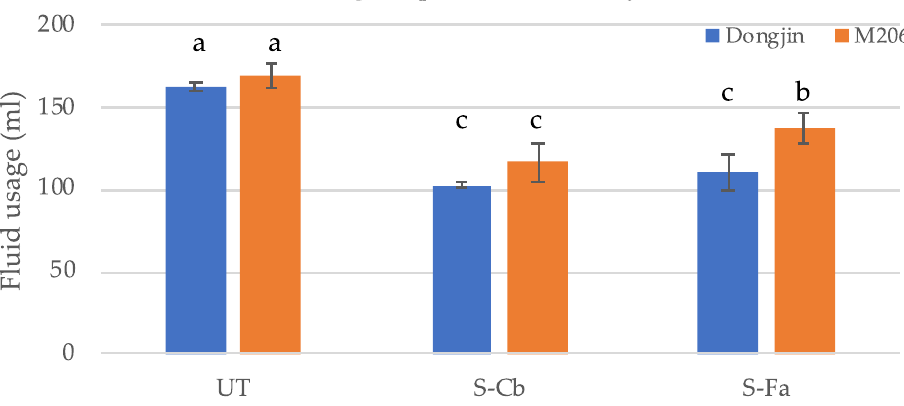
Figure 3. Fluid Consumption in Untreated and Treated Plants. Fluid consumption was measured on four-week old UT (untreated) and symbiotic (with SCb or SFa endophytes from weedy rice lines from drought and salt stress habitats, respectively) Dongjin (blue bars) or M206 (orange bars) rice plant varieties grown in double decker magenta boxes over a 14-day period. Statistical analysis indicated that S plants consumed less fluid compared to UT plants with S-Dongjin cultivar consuming the least amount of fluid (Duncan’s Multiple Range Test, p < 0.001). Different letters above the bars indicate statistically significant